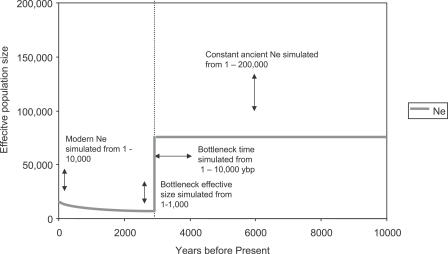
Model of the Population Bottleneck of C. sociabilis Showing a Constant Ancient Female Effective Population Size and Exponential Growth following a Decline in Population Size